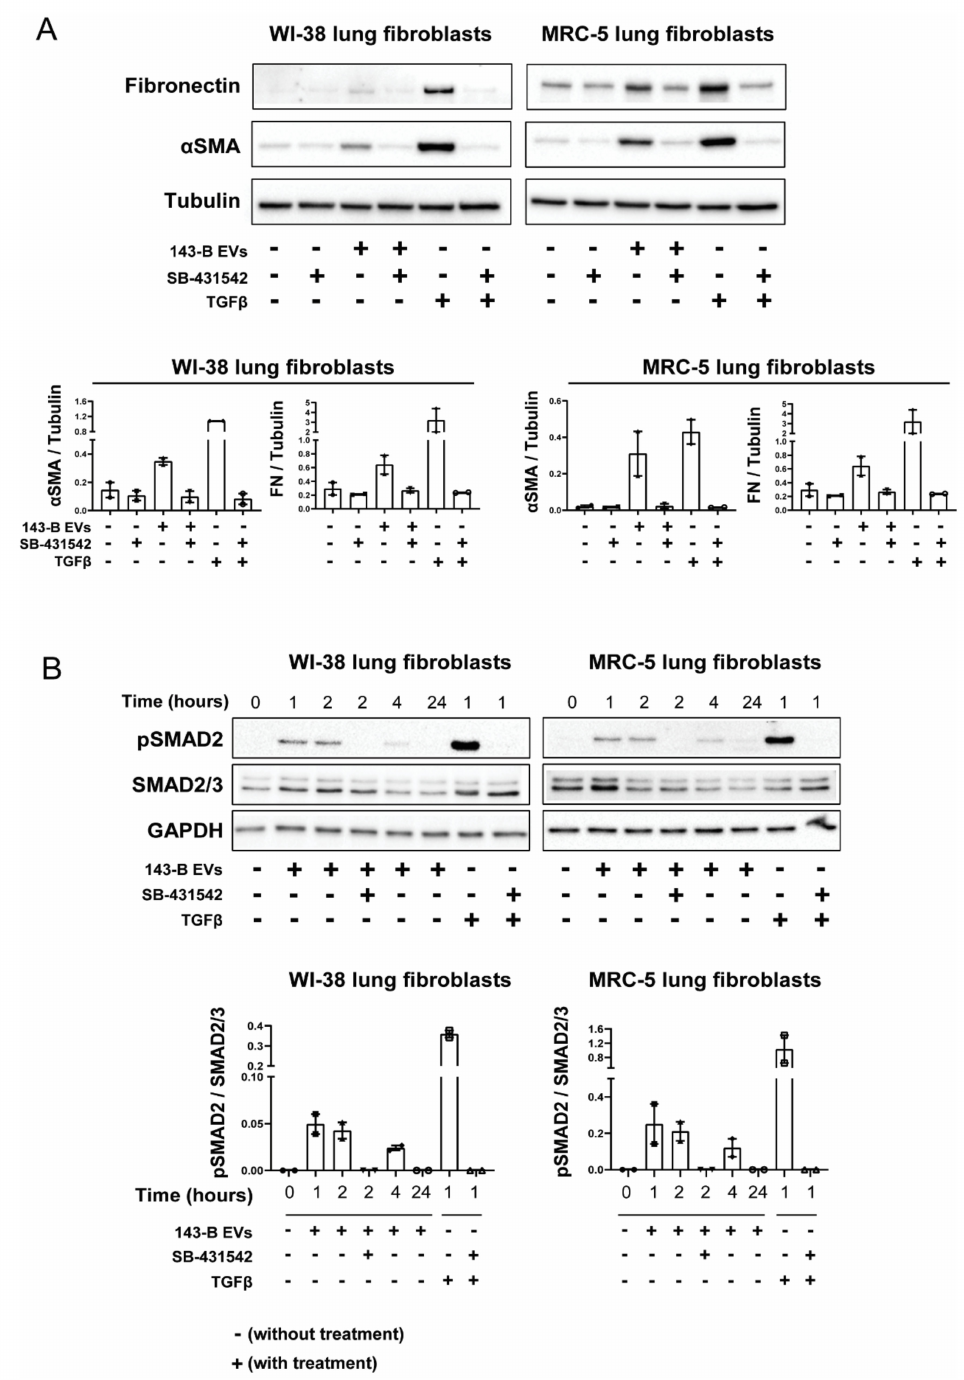
Figure 4. Osteosarcoma cell-derived EVs trigger α SMA expression in lung fibroblasts through TGF β . ( A ) Western blot analysis of fibronectin and α SMA protein expression in WI-38 and MRC-5 fibroblasts upon exposure to 20 µ g / mL 143-B-derived EVs and 10 ng / mL of soluble TGF β 1 for 48 h with or without pre-treatment with a TGF β receptor 1 inhibitor SB-431542 (10 µ M) for 30 min. ( B) E ff ects of 143-B EVs on SMAD2 phosphorylation in lung fibroblasts. Serum-starved (24 h) WI-38 and MRC-5 cells were left untreated or were pre-treated for 30 min with SB-431542 (10 µ M) prior to incubation with 143-B EVs (20 µ g / mL) or TGF β 1 (10 ng / mL) for the indicated periods of time. Protein expression of phosphorylated SMAD2, total SMAD2 / 3 and GAPDH was evaluated by Western blot. Representative Western blots (upper panels) and respective quantitative analysis of two independent experiments (lower panels) are